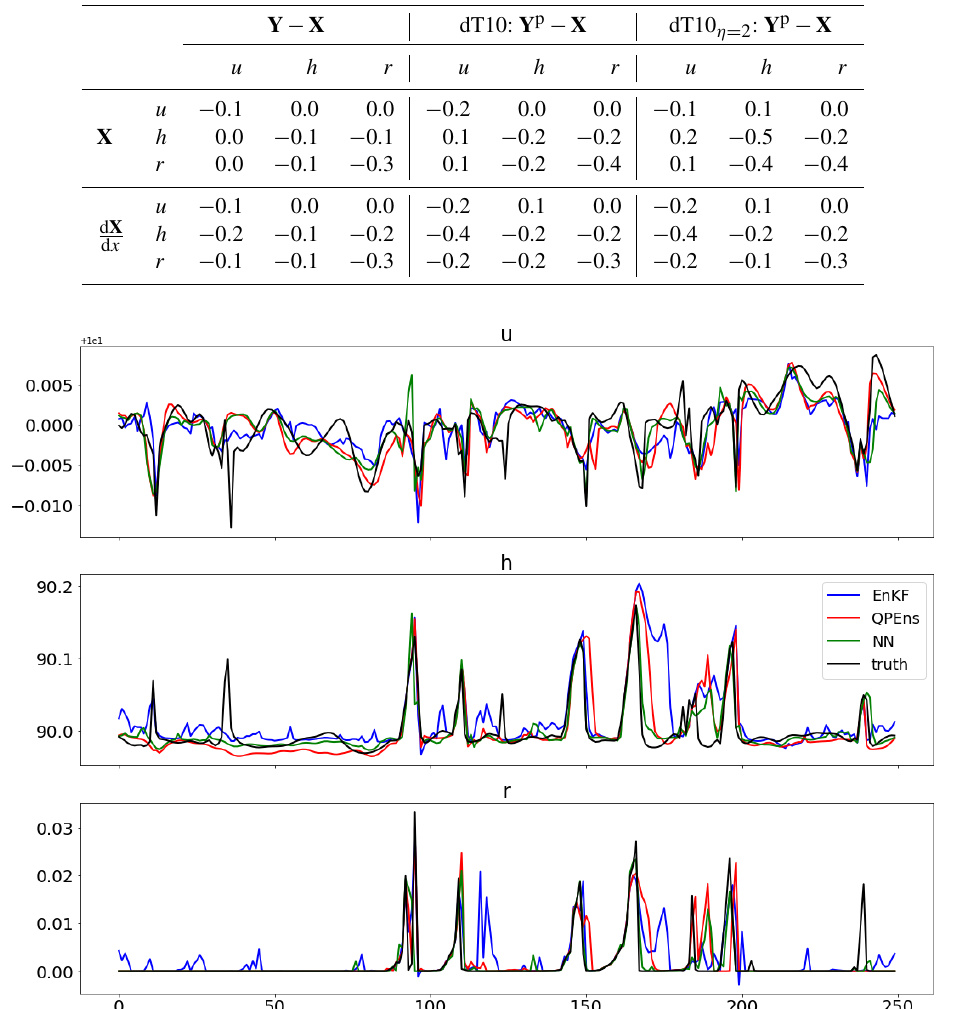
Table 3. Correlation coefficient for increments of the output (left column) and the prediction for dT10 (middle column) and dT10 η = 2 (right column) with the input (top row) and the gradient of the input (bottom row).